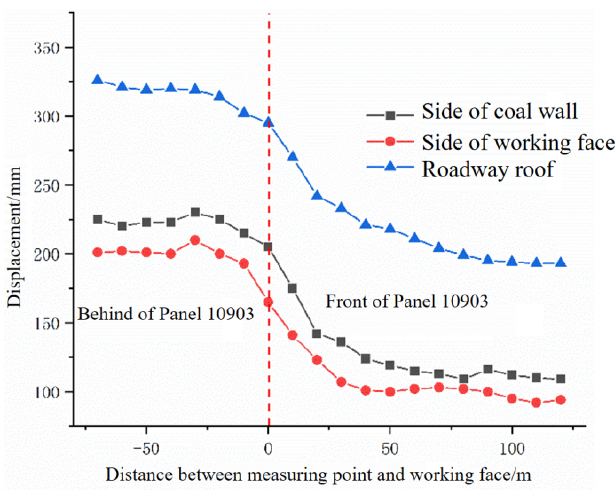
Figure 21. Displacement curve of the surrounding rock of the roadway.